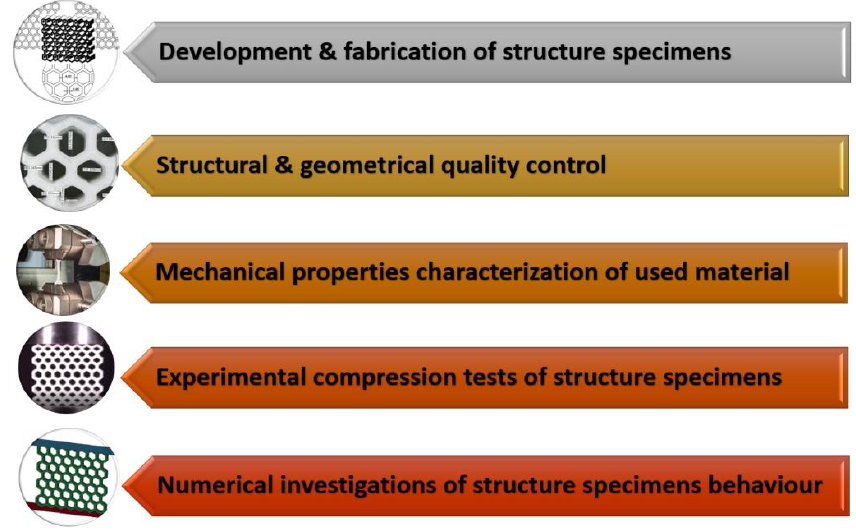
Figure 1. The main steps of applied research methodology.